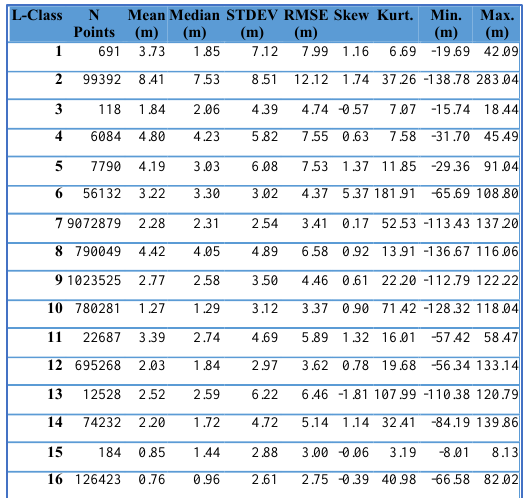
Table 2. Statistics for elevation differences SRTM90 – h_te_interp (in m) with respect to MODIS 0.5 km land Cover